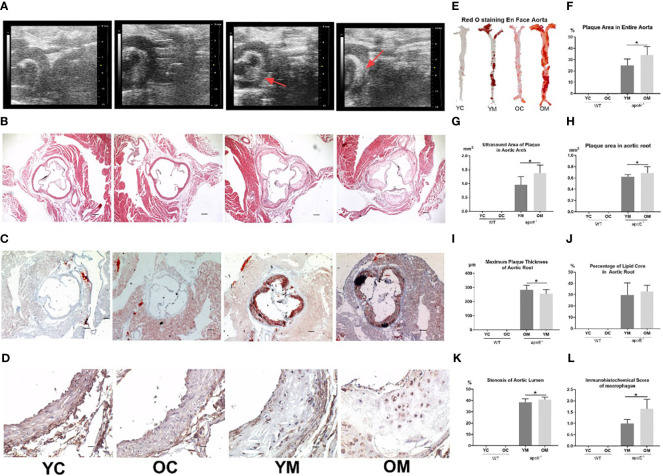
Quantification of AS, n=6 mice per group. (A) Representative images of aortic arch ultrasound, (B) HE and (C) Red O staining of aortic root sections (All images were taken at 40× magnification), and (D) immunohistochemical staining for macrophages infiltration in the atherosclerotic plaque of aortic root sections (All images were taken at 200× magnification); (E) En face analysis of aortas. Atherosclerotic lesions were identified by oil-red-O staining; (F) Total area of atherosclerotic lesion in the entire aortas; (G) Atherosclerotic plaque area in aortic arch (ultrasound); (H) Atherosclerotic plaque area in aortic root; (I)Thickness of maximum plague in aortic root; (J) The percentage of lipid core in atherosclerotic plaque of aortic root. (K) Percentage of stenosis at aorta lumen; (L) Score of macrophages infiltration in the atherosclerotic plaque in aortic root. Data were shown as mean ± SD. *p <0.05; p values are calculated from T-test.